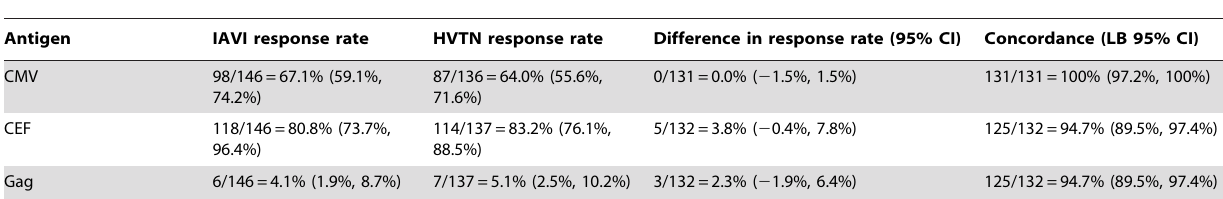
Table 3. Results on the comparison of response rates and positivity calls in the inter-laboratory comparison study.